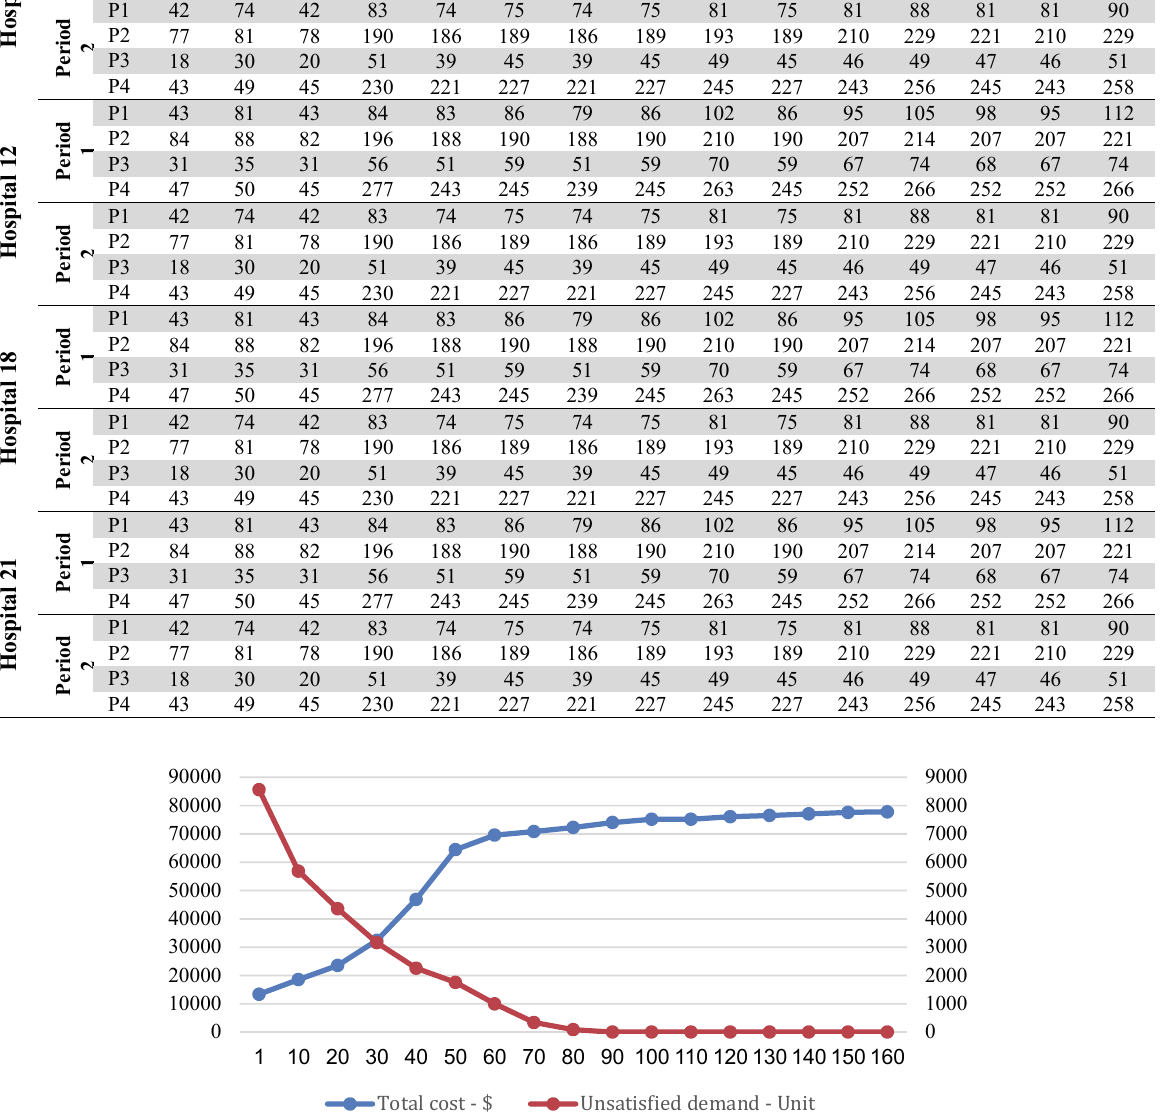
Fig. 5. Tradeoff between minimizing total costs’ objective and maximizing satisfied